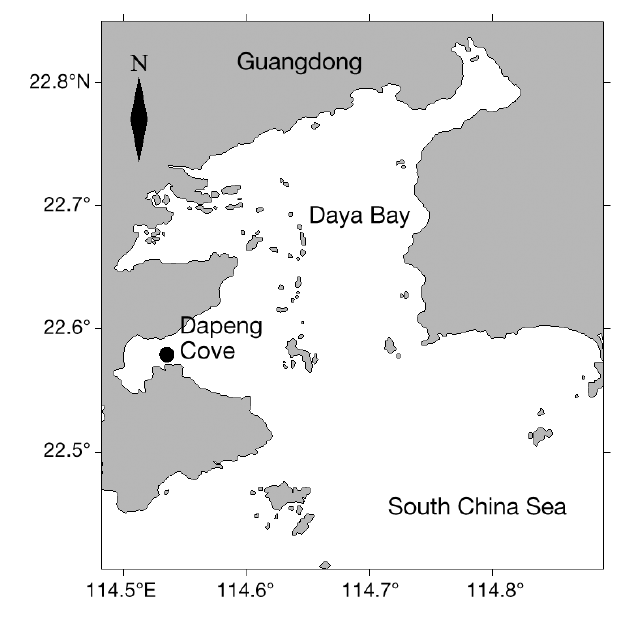
Fig. 1. Location of the study area ( D ) in Daya